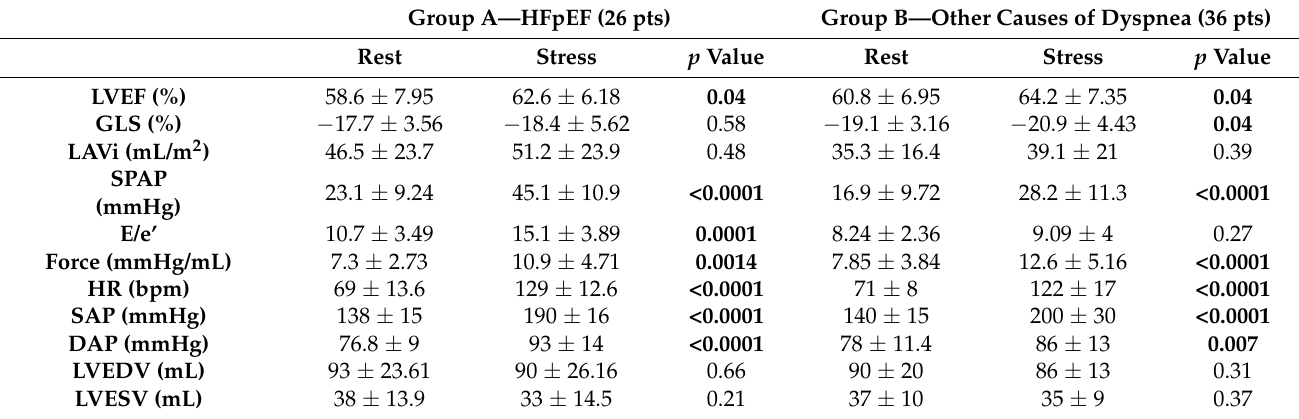
Table 2. Echocardiographic changes between rest and stress in group A and group